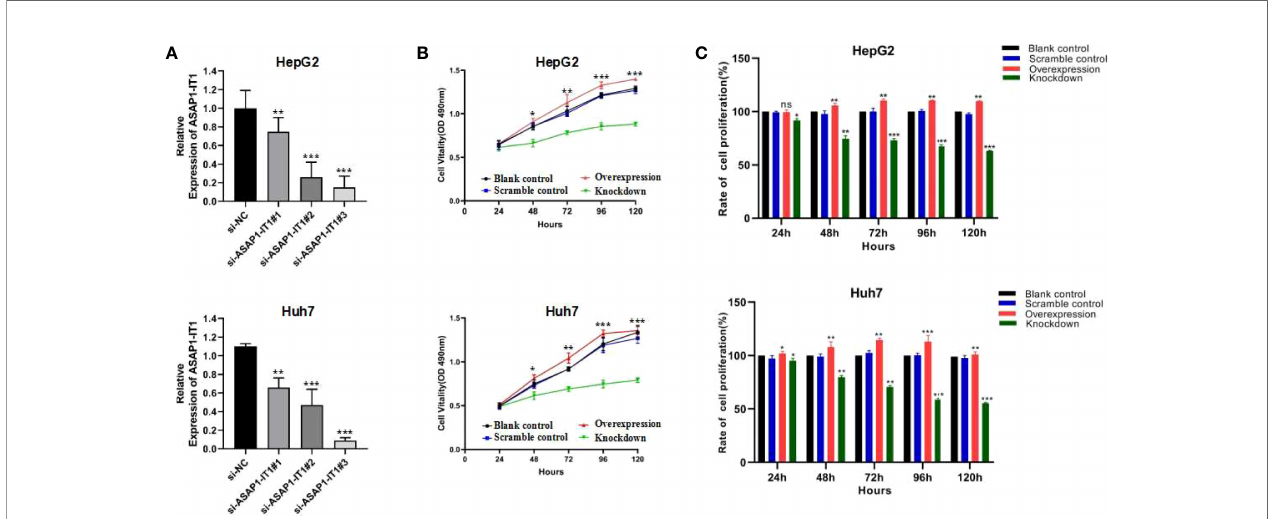
FIGURE 3 | Effects of ASAP1-IT1 on cell proliferation in HepG2 and Huh7 cells. (A) Knock-down of ASAP1-IT1 in HepG2 and Huh7 cells transfected with ASAP1- IT1-speci fi c small interfering (si)RNAs or nonspeci fi c (NC) siRNA (si-NC) as a control in HepG2 (upper panel) and Huh7 (lower panel) cells. (B) MTT assay for cell viability. ASAP1-IT1 siRNA signi fi cantly suppressed cell viability compared with control groups, while overexpression of ASAP1-IT1 signi fi cantly increased cell viability in HepG2 (upper panel) and Huh7 (lower panel) cells. (C) Comparison of cell proliferation rates between groups in HepG2 (upper panel) and Huh7 (lower panel) cells. Data were expressed as mean ± standard deviation (SD) of at least three independent experiments. n.s., Not statistically signi fi cant; *p < 0.05, **p < 0.01, ***p < 0.001 vs control